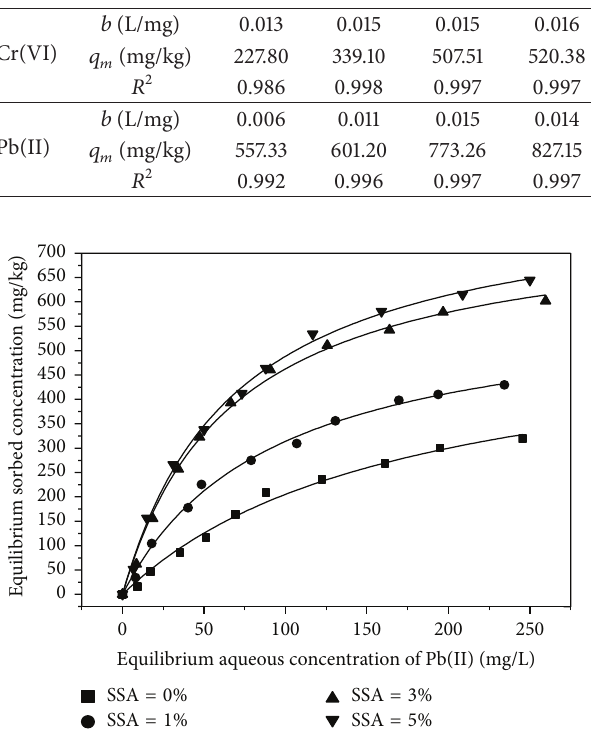
Figure 4: The adsorption isotherm for Pb(II) with modified